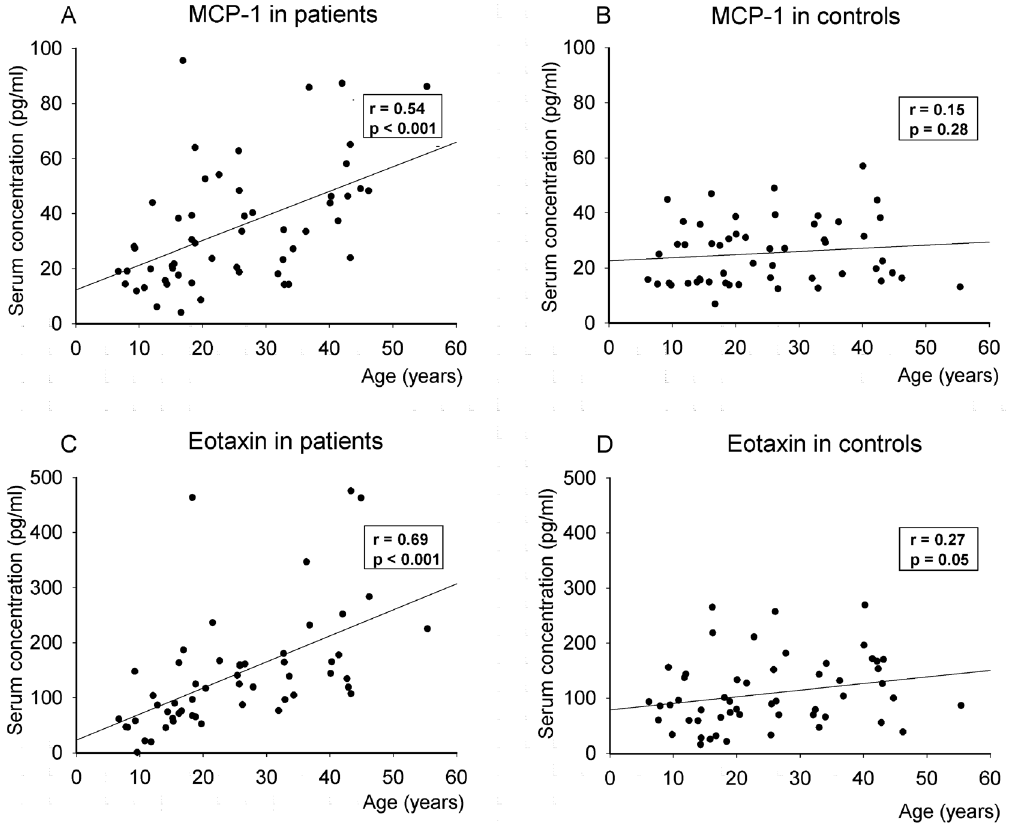
Figure 1. Correlations between monocyte chemoattractant protein-1 (MCP-1) (A and B) and eotaxin (C and D) and age, in 54 patients with juvenile dermatomyositis and sex- and age-matched controls. r, Spearman correlation coefficient.